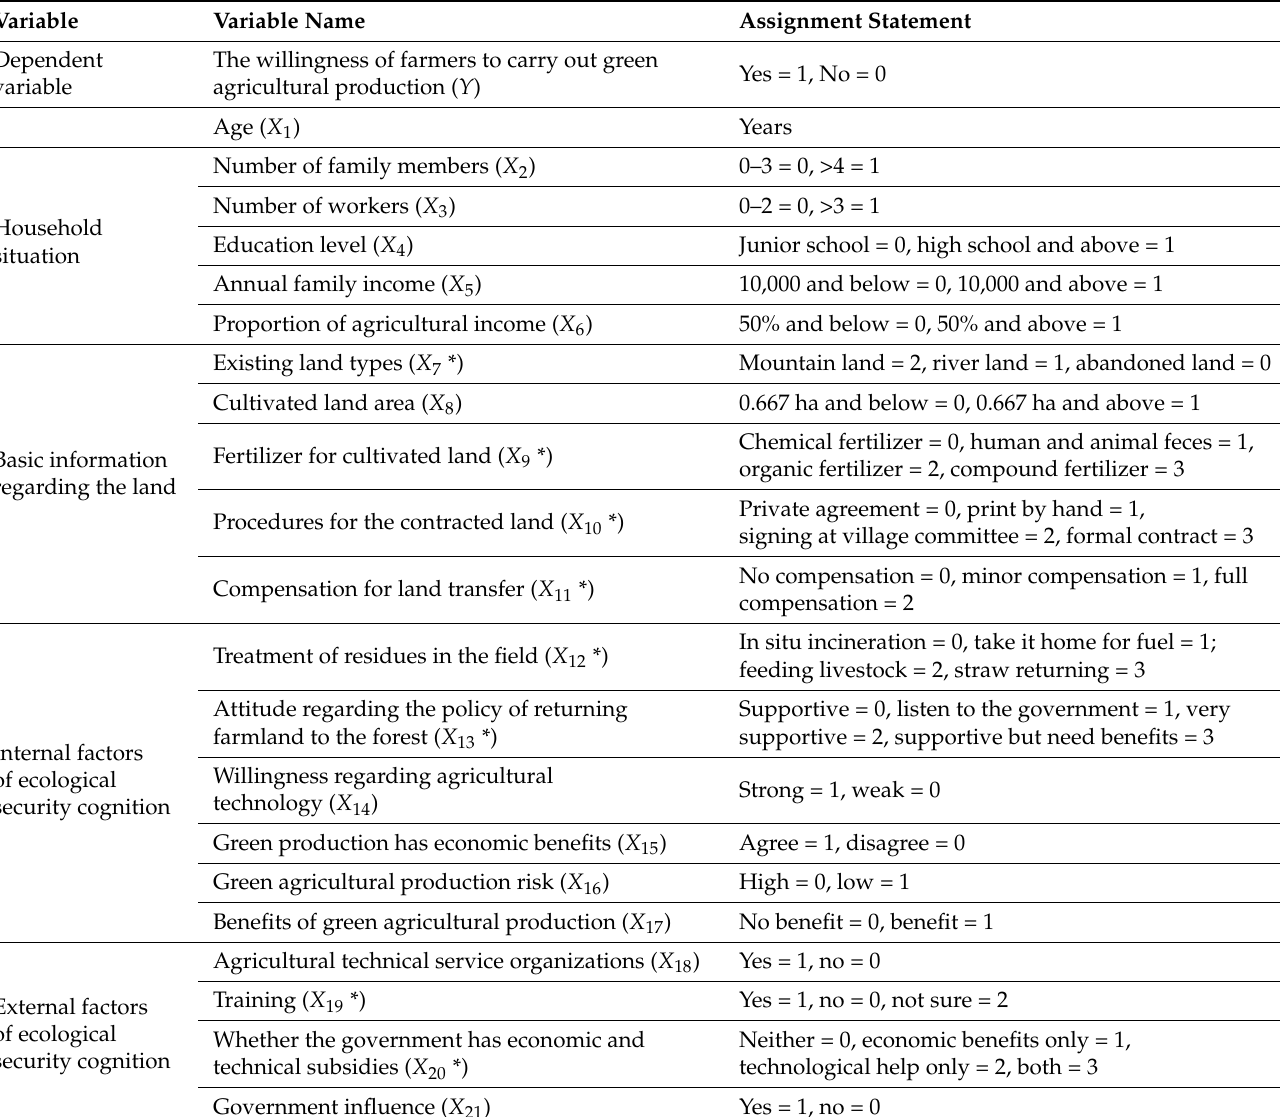
Table 2. Variables and